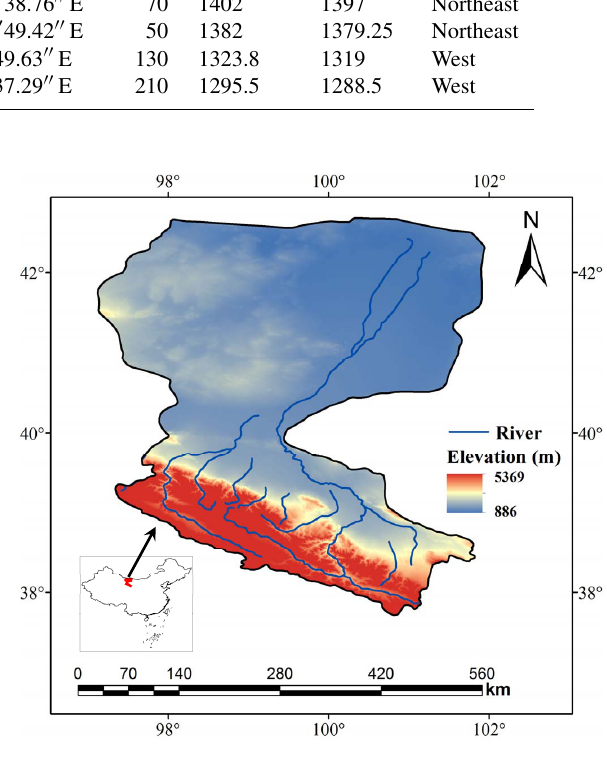
Figure 2. Study area and location of the Heihe River basin in north- west